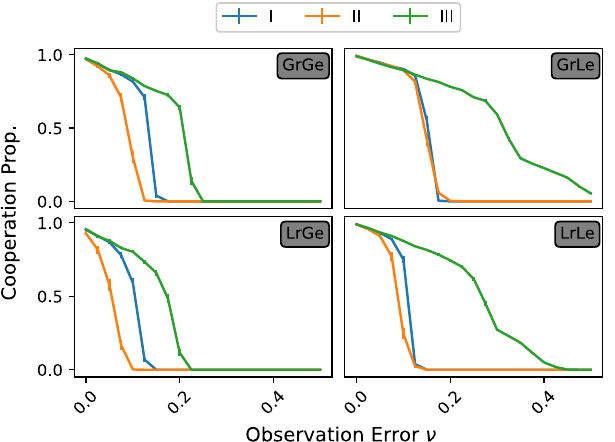
Figure 3. Effect of observation error ν on the proportion of cooperation. Global reputation provides a slight advantage over local reputation. Local learning shows increased resilience against more likely errors in observation mostly for group III strategies. Additionally, there is little to distinguish between the behaviour of groups I and II under local learning, particularly in combination with global